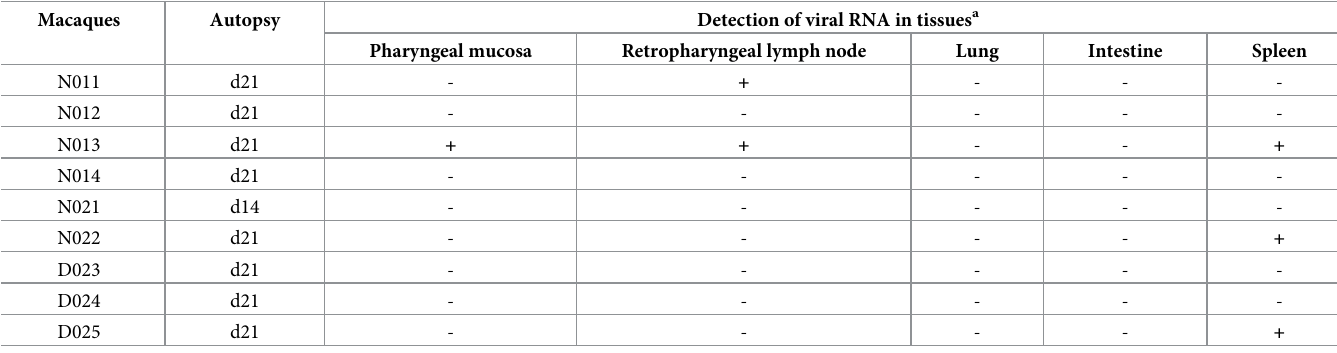
Table 3. Detection of viral RNA in tissues obtained at